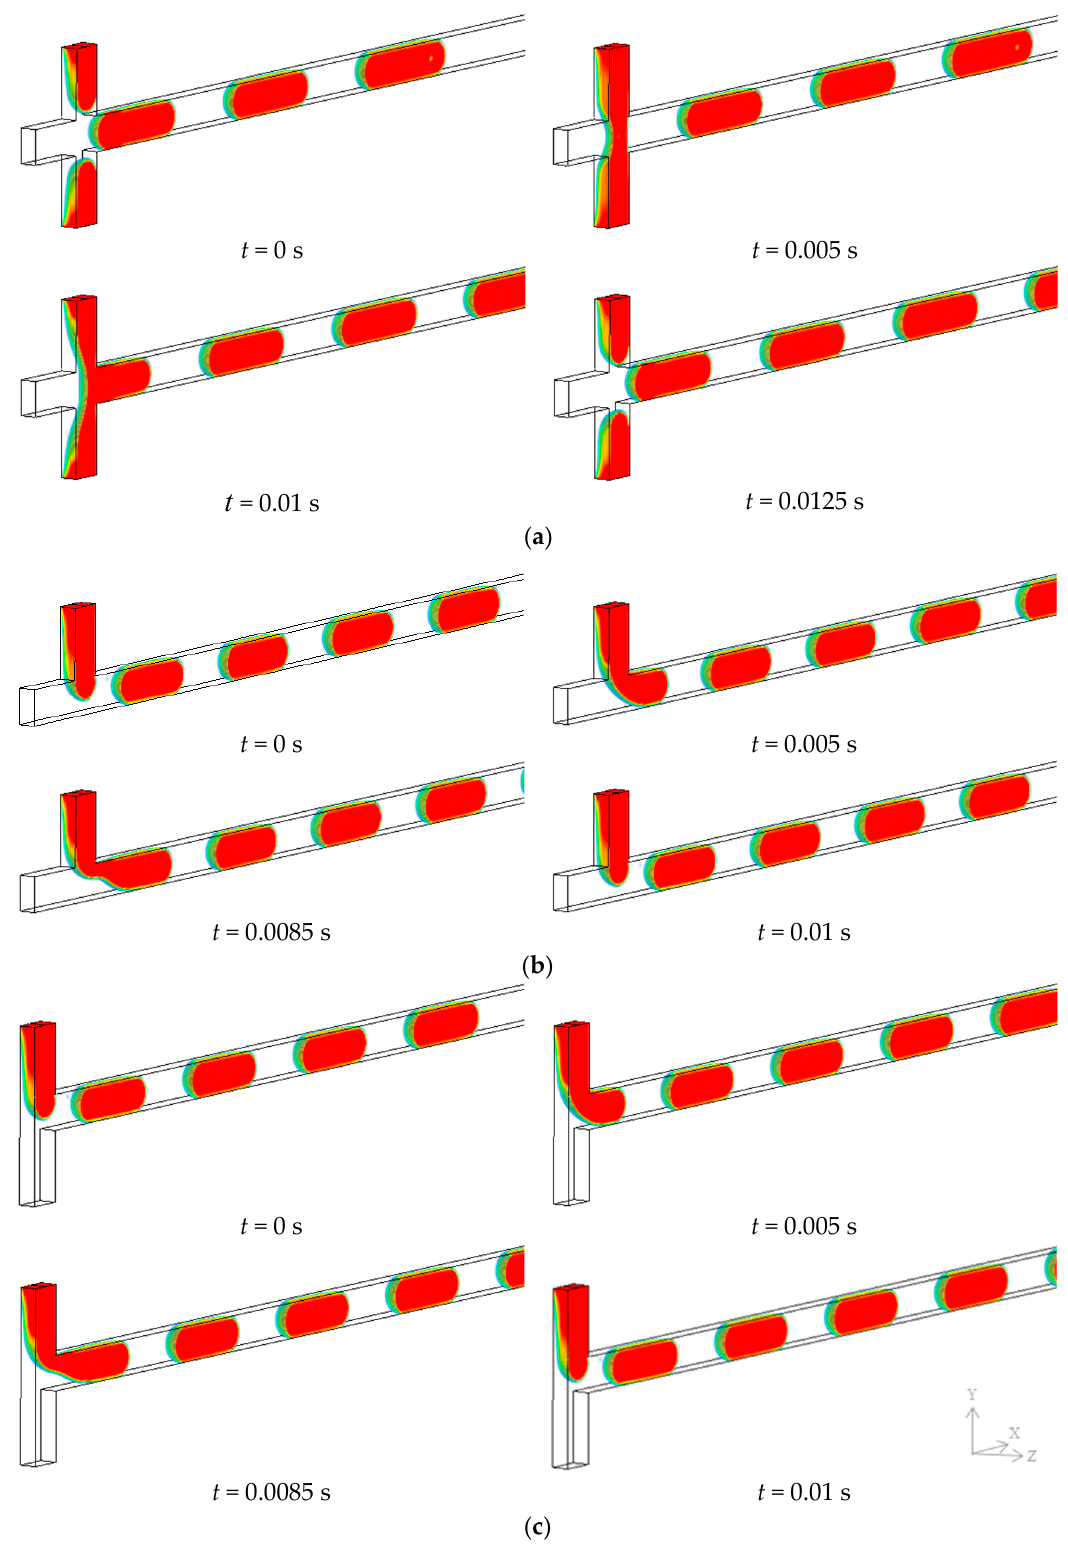
Figure 3. Droplet formation process in three junction configurations. u total = 50 mm/s, ε d = 0.5. ( a ) Droplet formation process in the cross-shaped junction; ( b ) Droplet formation process in the cross-shaped T-junction; ( c ) Droplet formation process in the T-junction.